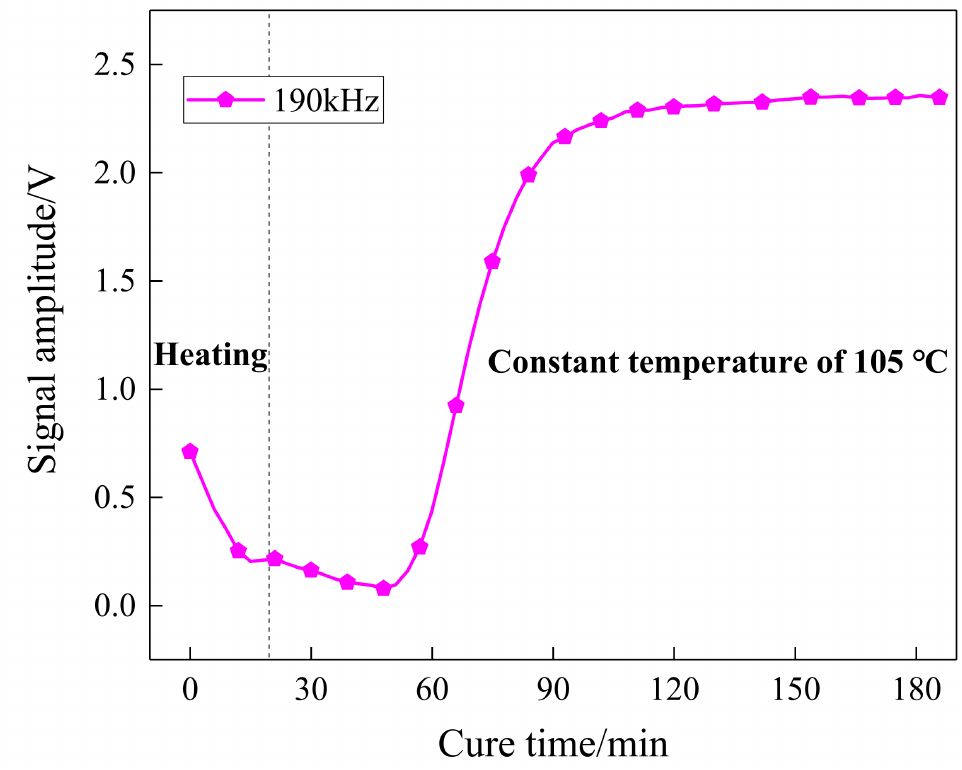
Figure 7. The variation amplitude of the P7_4 sensing path over